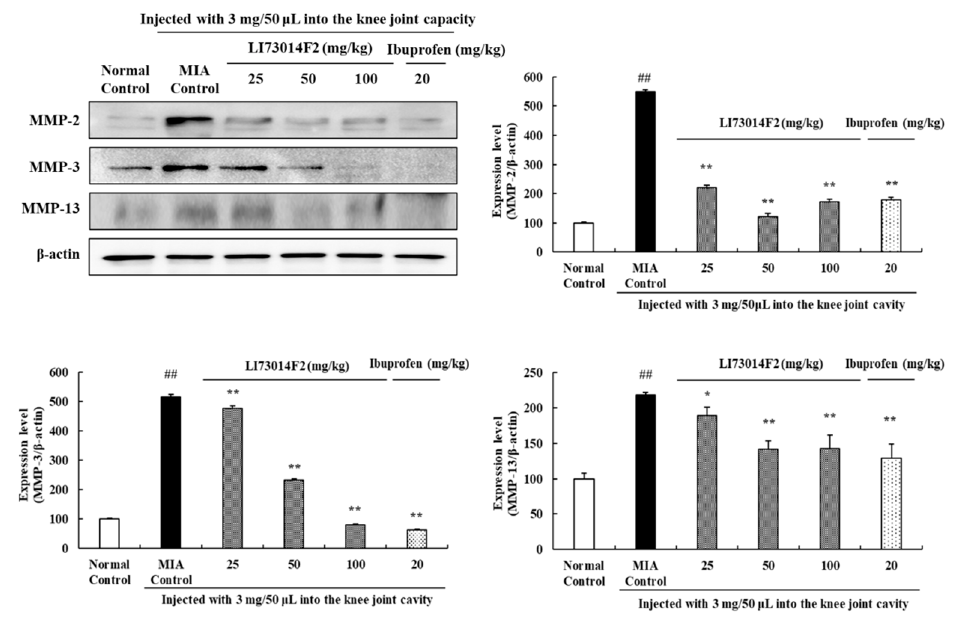
Figure 5. E ff ects of LI73014F2 on the expression levels of matrix metalloproteinases (MMPs) in articular cartilage. The expression levels of MMP-2, MMP-3, and MMP-9 were determined using Western blot analysis; density of the protein bands was quantified and calculated using ImageJ software. Protein expression levels were normalized to those of β -actin and are expressed as mean ± SEM of independent experiments ( n = 3 / group). * p < 0.05 and ** p < 0.01, compared to the MIA-induced control group; ## p < 0.01, compared to the non-MIA-induced control group.